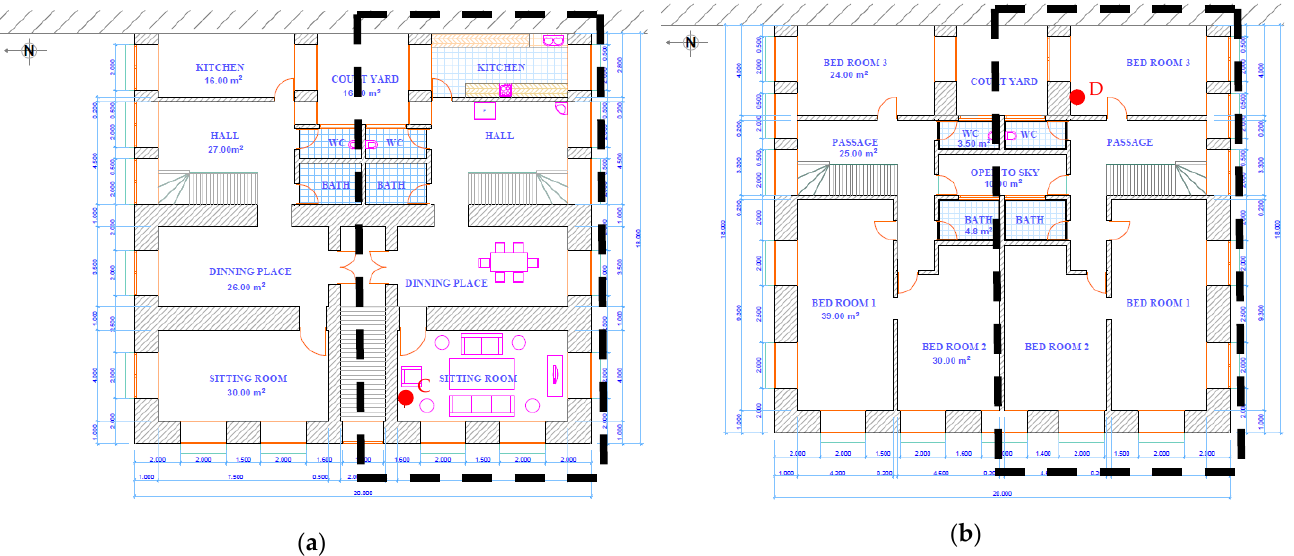
Figure 3. Floor plan for HRB2. The positions of the thermohygrometers are marked with red dots (Points C and D). Spaces enclosed with dashed lines were studied in this research. ( a ) First floor, ( b ) Second floor.